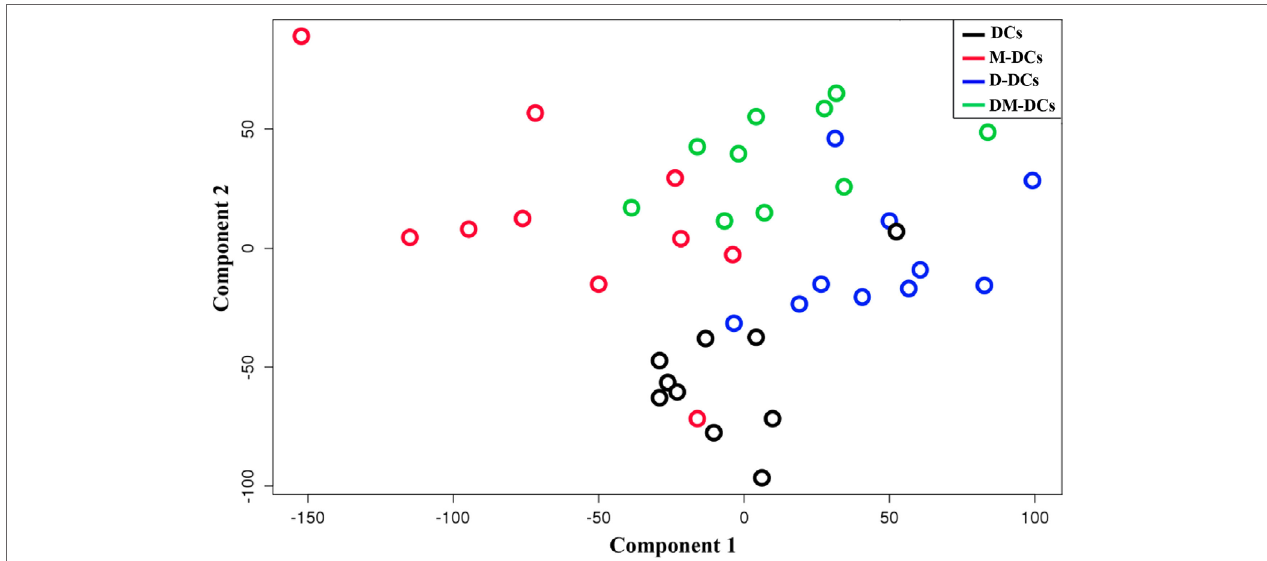
FigUre 1 | Different stimuli used for monocyte-derived DCs (moDCs) differentiation induces a particular transcriptional profile that distinguishes them from other subtypes. Principal component analysis of the two first components allows separation of all four moDCs experimental groups according to variance